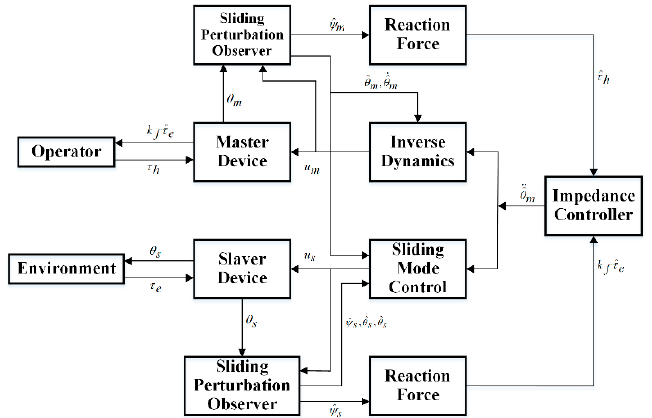
Figure 5. Structure of bilateral control.